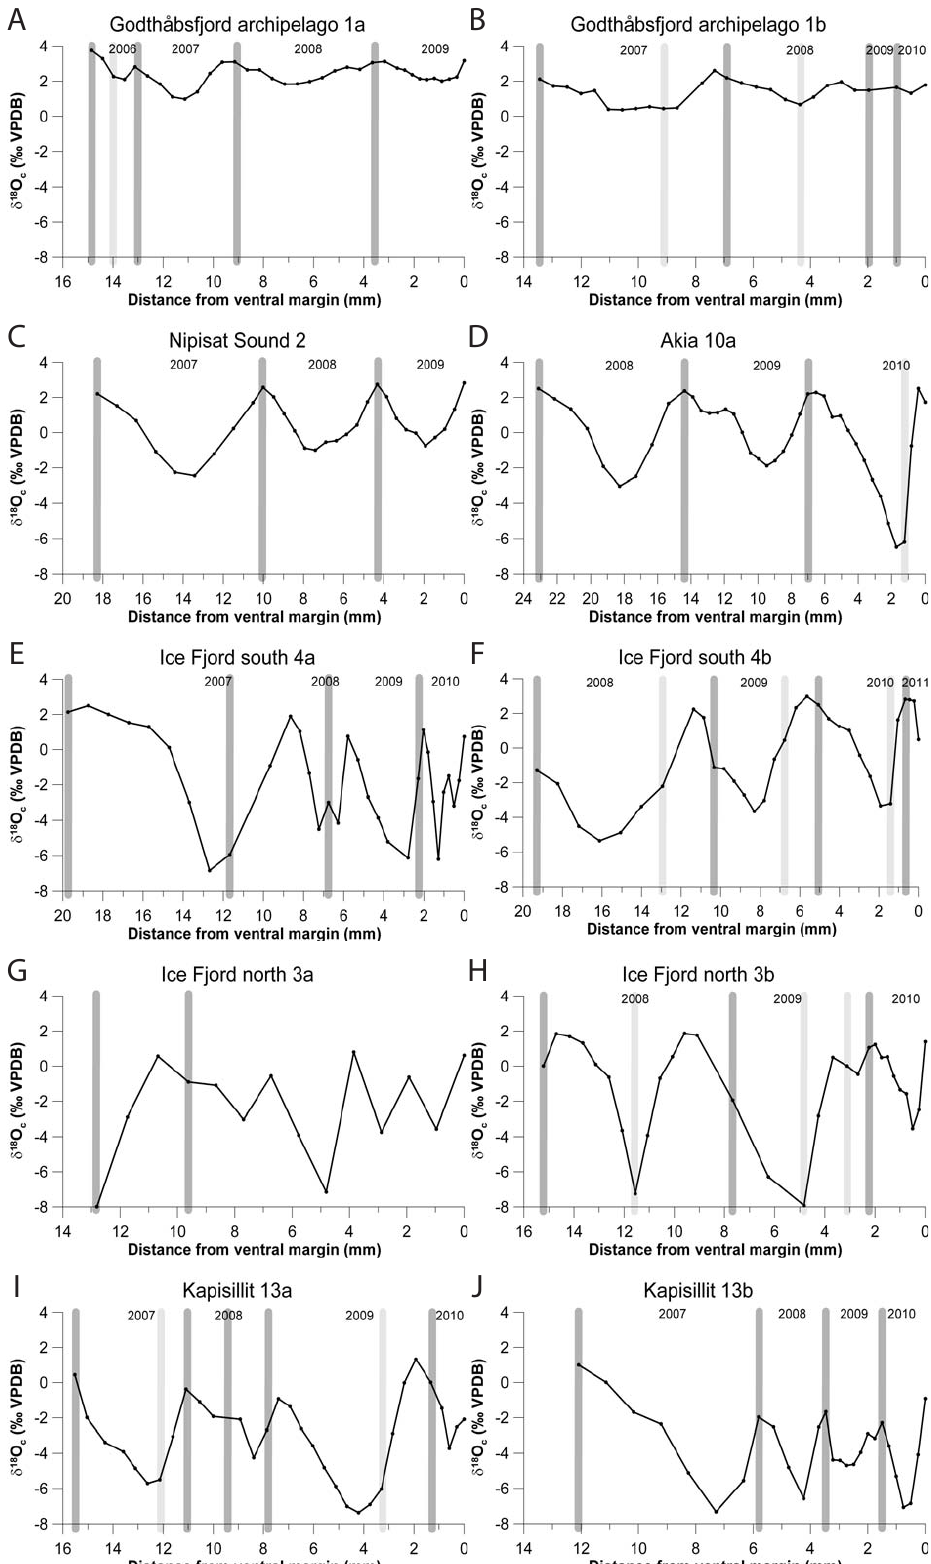
Fig. 4. Seasonal δ 18 O c graphs of shells. In dark grey distinct dark growth lines (expected to be annual growth cessations) are indicated, in light grey less profound dark lines observed in the